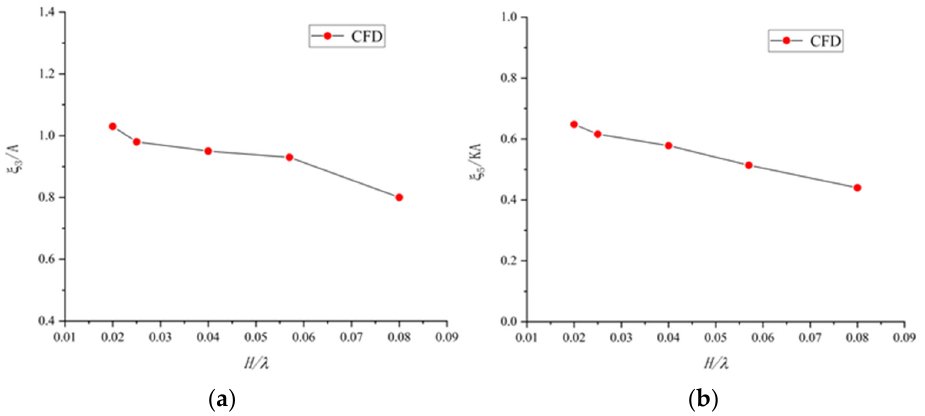
Figure 19. RAOs of Yukun hull for different wave steepness. ( a ) Heave; ( b )